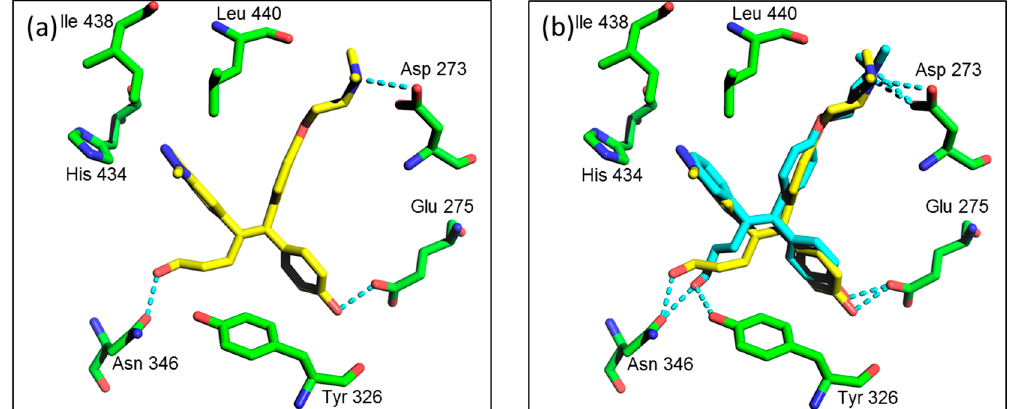
Figure 3. Proposed binding model of compound 15g . ( a ) The protein structure originated from the X-ray structure of its complex with 4 (pdb code: 2ewp). ERR γ is shown in a green color and the hydrogen bond interactions with compound 15g is shown as dotted lines; ( b ) Comparison of the proposed binding mode of compound 15g and 4 with ERR γ .